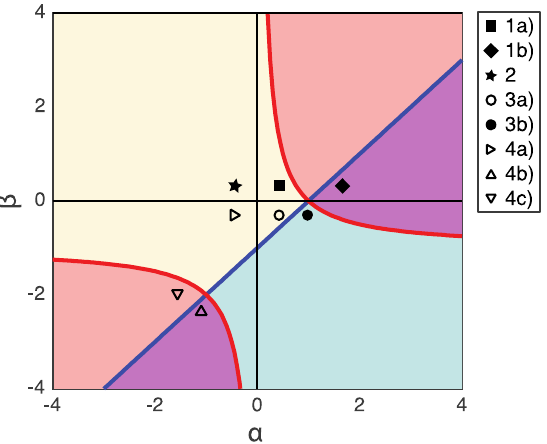
Figure 5. The payoffs in each figure are shown in α vs. β plane. The regions where α ( β + 1) > 1 is shaded with pink color, and the regions where α > β + 1 is shaded with blue color. The overlapped region ( α ( β + 1)>1 and α > β + 1) is purple. The scenarios with bistability are labeled with open markers. The scenarios with unique stability are labeled with solid markers.